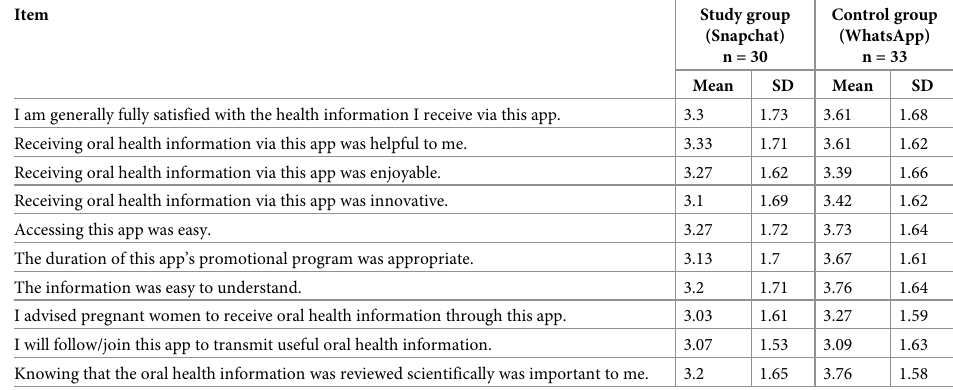
Table 6. Study participants’ responses to receiving information in Snapchat (study group) or WhatsApp (control group).